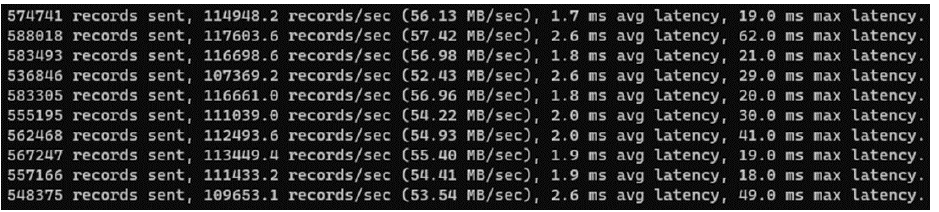
Figure 18. Screenshot of data processing log for performance evaluation.